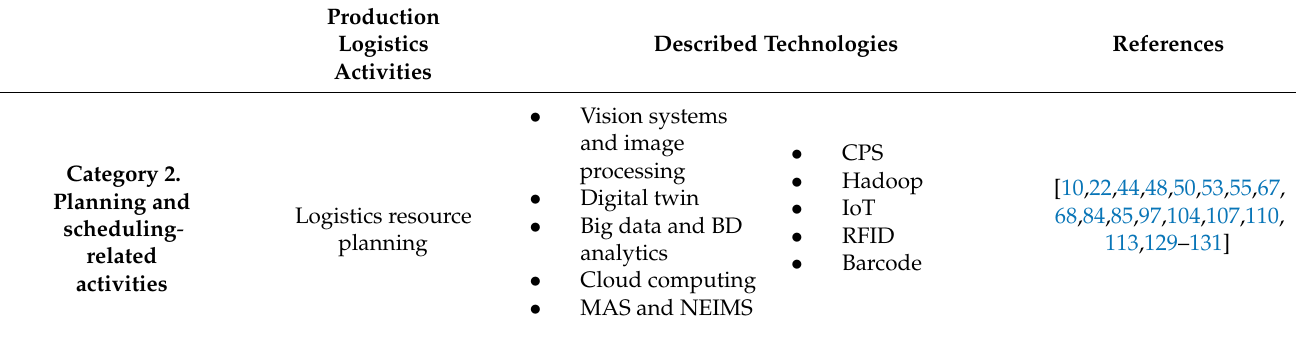
Table 4. Production logistics activities in Category 2 and association with the identified technologies in the